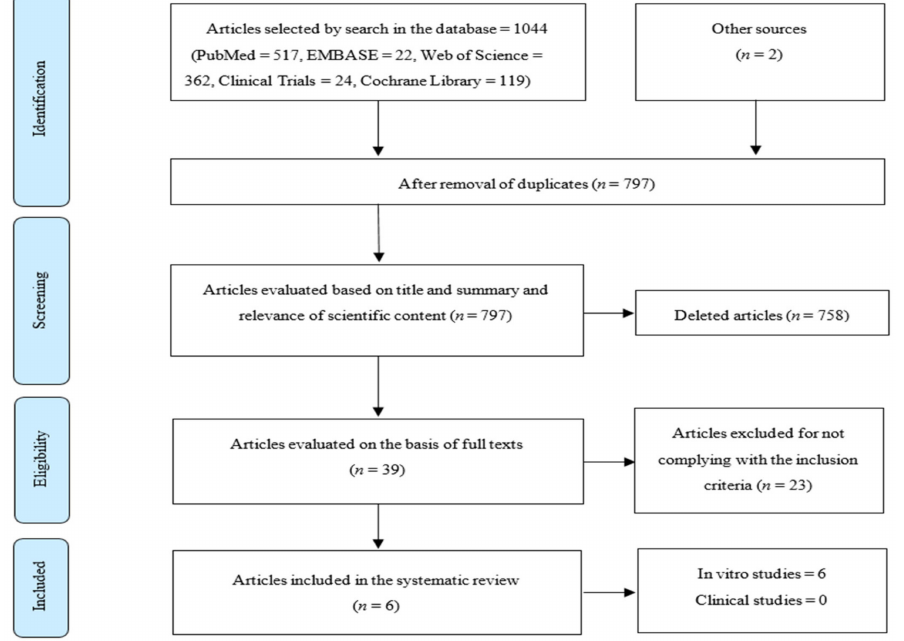
Figure 1. Preferred Reporting Items for Systematic Reviews and Meta-Analysis (PRISMA) flow diagram of the study selection